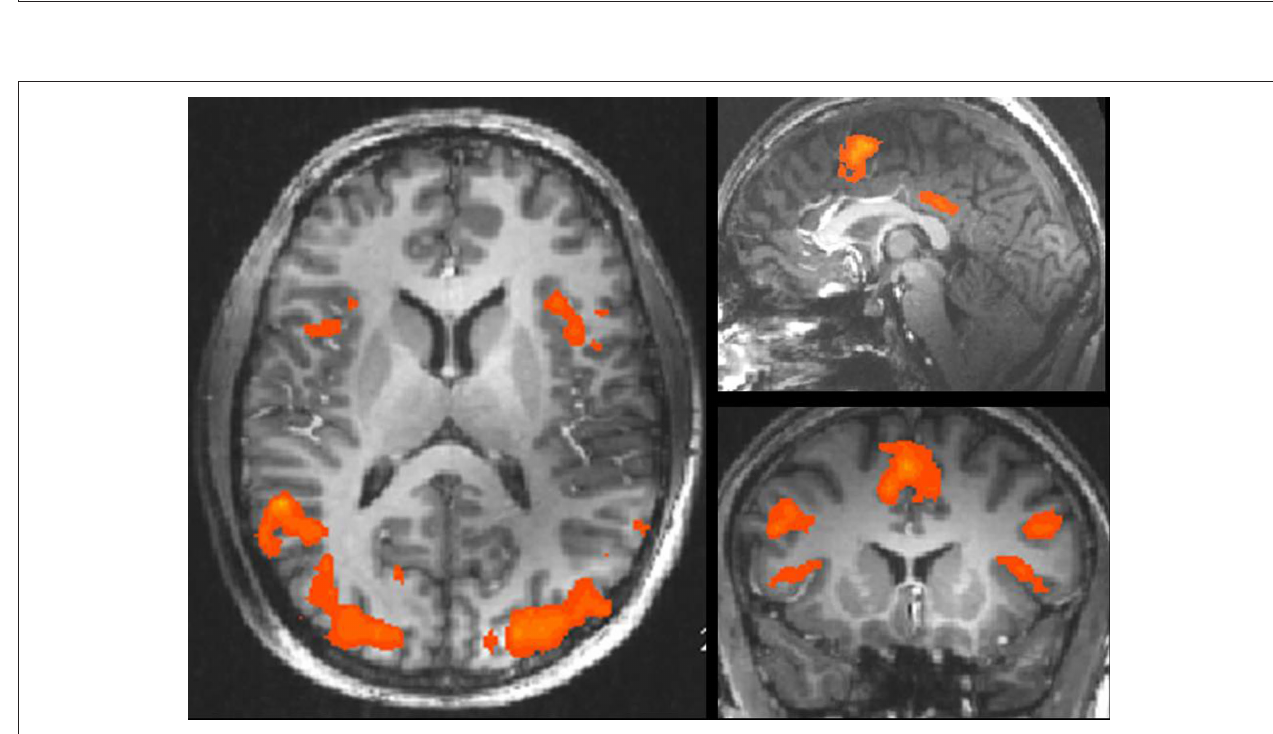
FIguRe 2 | Thalamic activation during anticipation and picture period. Thalamic activation for the conjunction [erotic pictures × emotional pictures] revealed the bilateral mediodorsal thalamus (red voxels) while the anticipation period, examined by the conjunction [erotic anticipation × emotional